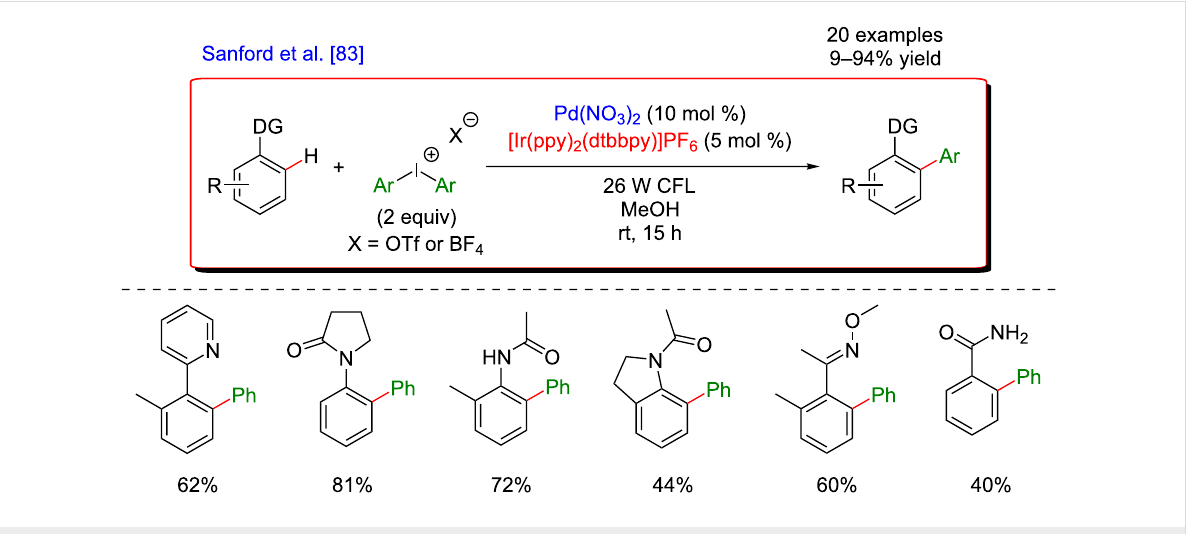
The same year, a similar arylation was disclosed by Balaraman et al. using eosin Y as a photoredox catalyst (Figure 24)